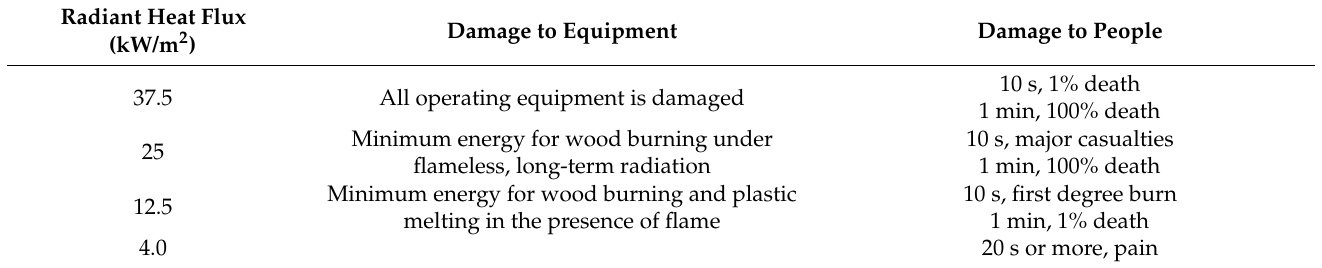
Table 7. The hazardous level of radiant heat